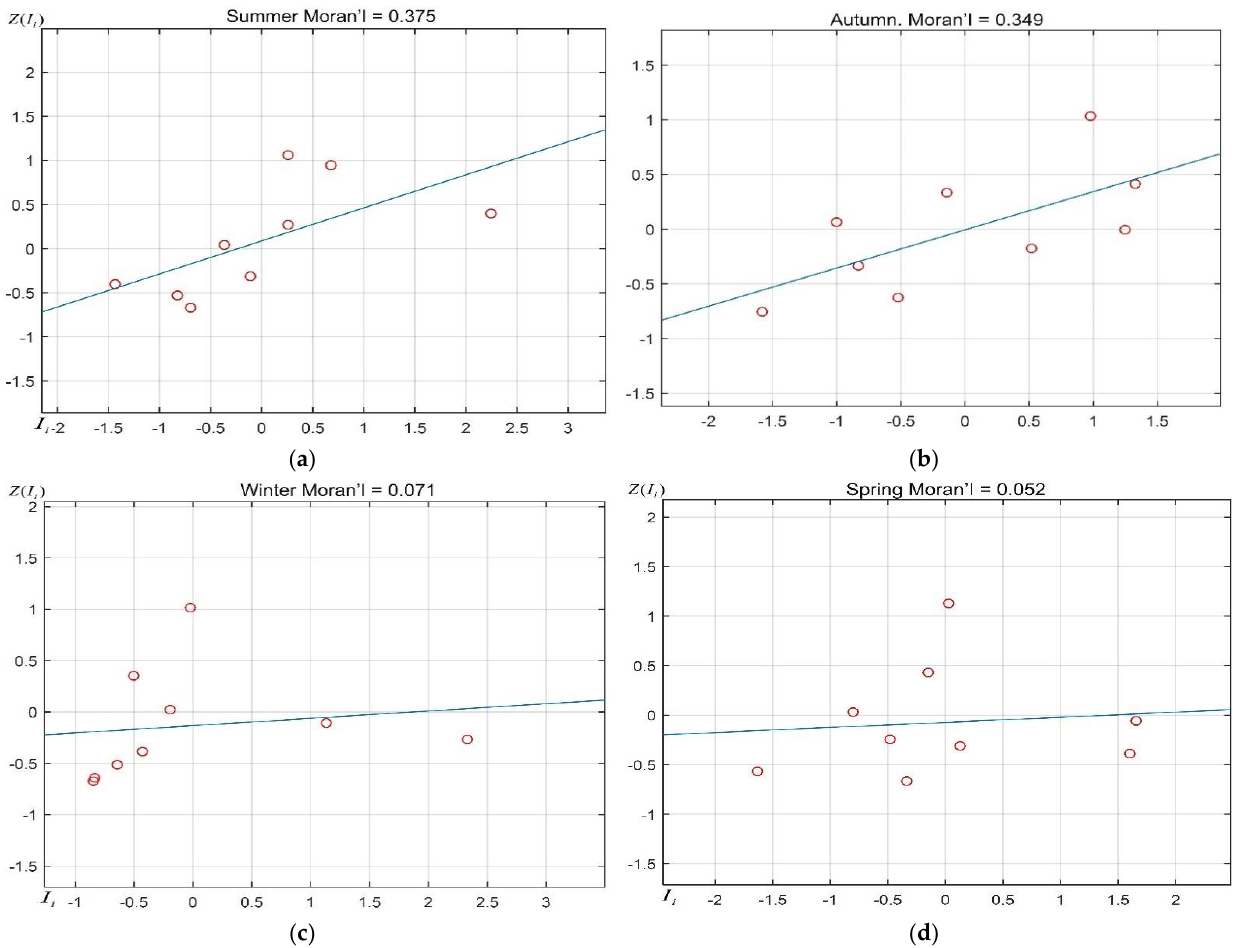
Figure 6. the Moran scatter plot in and respectively. ( a ) summer, ( b )autumn, ( c ) winter, and ( d ) spring.